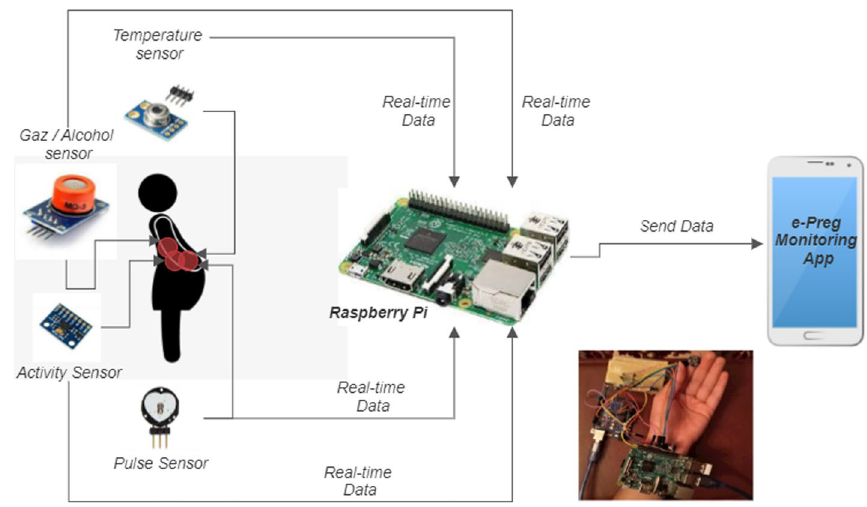
Fig. 3 IoT implementation for gathering healthcare sensor